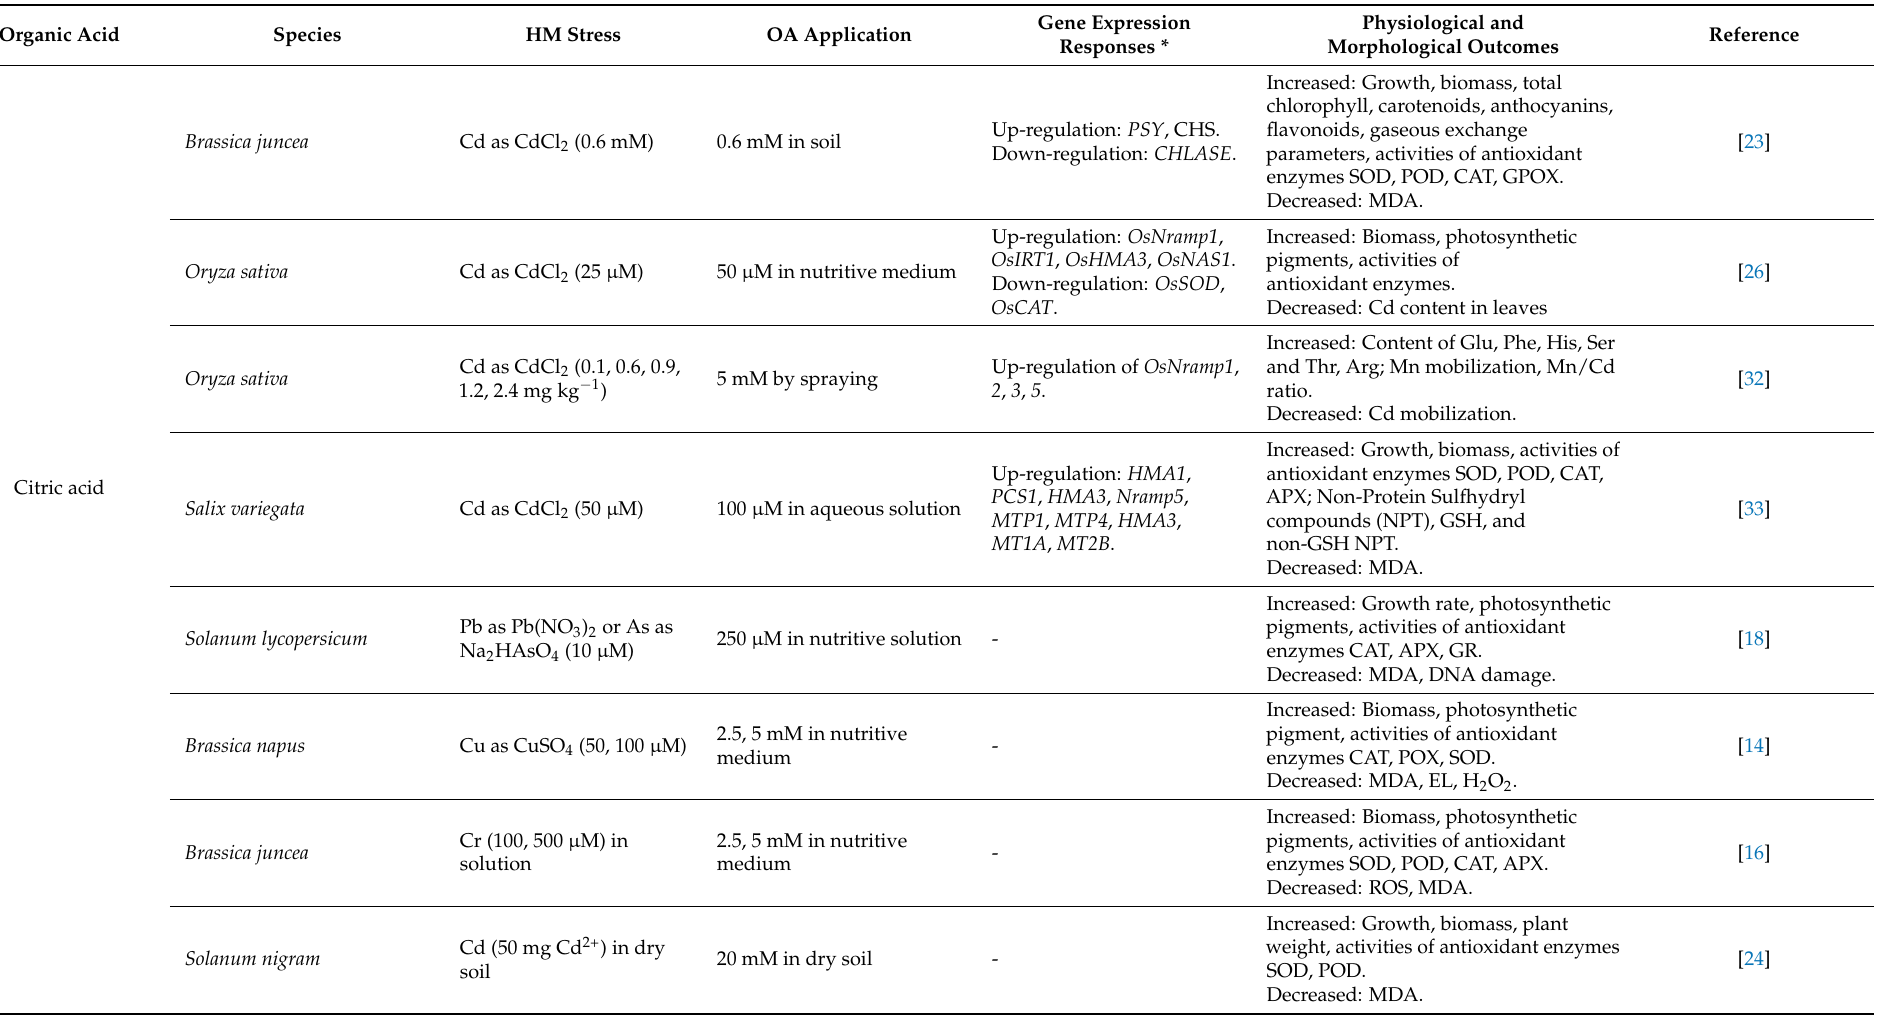
Table 2. The molecular and physiological effects of exogenous organic acid applications to crop species subjected to heavy metal